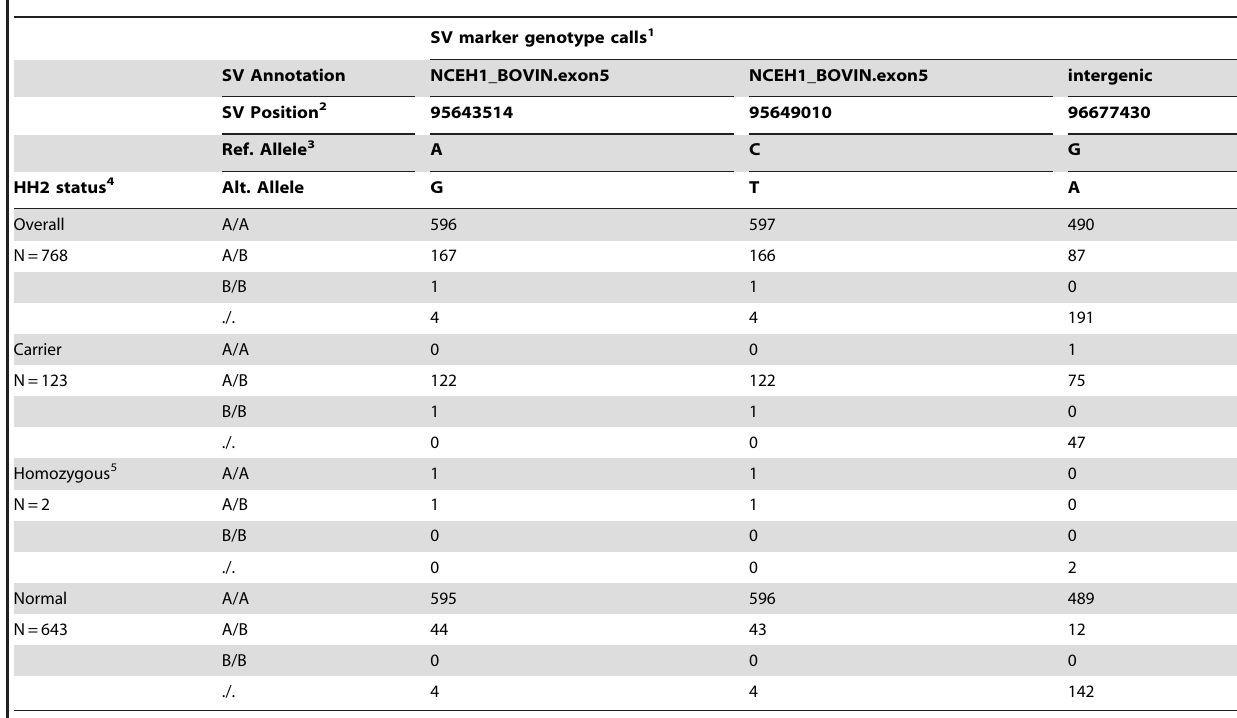
1 Columns represent the 3 candidate SV markers genotyped to compare concordance with HH2 animal status. 2 UMD 3.1 genome coordinates on Chr 1. 3 Ref. Allele is designated as ‘‘A’’ and represents the base call in the genome assembly and Alt. Allele is designated as ‘‘B’’ and represents the variant discovered by exome sequence data. ‘‘./.’’ indicates that no genotype was called. 4 SV genotyped animals were grouped based on refined HH2 status as determined by BovineSNP50 genotypes; ‘‘Overall’’ represents summary of all animals together. 5 Holstein animals homozygous for sub-segments of refined HH2 based on BovineSNP50